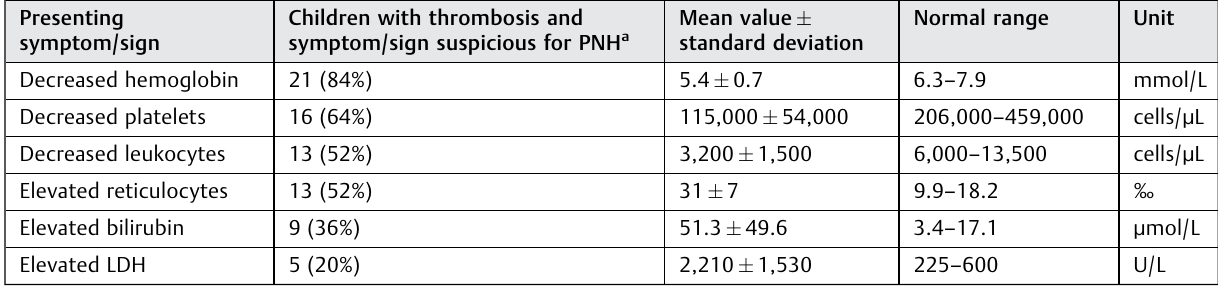
Table 1 Presenting laboratory characteristics of 25 children with con fi rmed thrombosis at the Department of Paediatrics at the Medical University of Innsbruck, Austria, between 2004 and 2013 Presenting Children with thrombosis symptom/sign